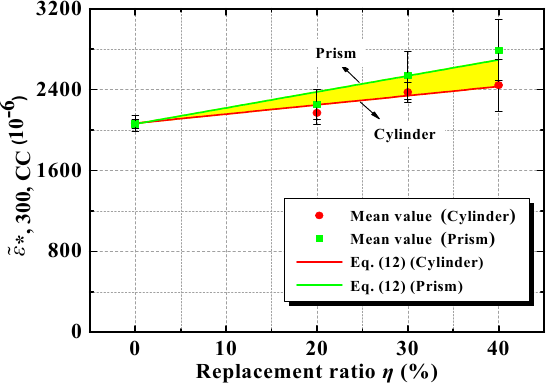
Figure 13. Variation of combined peak strain with replacement ratio of DCLs.